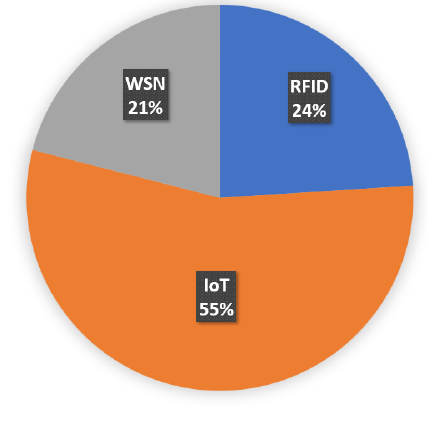
Figure 3. Distribution of publications based on